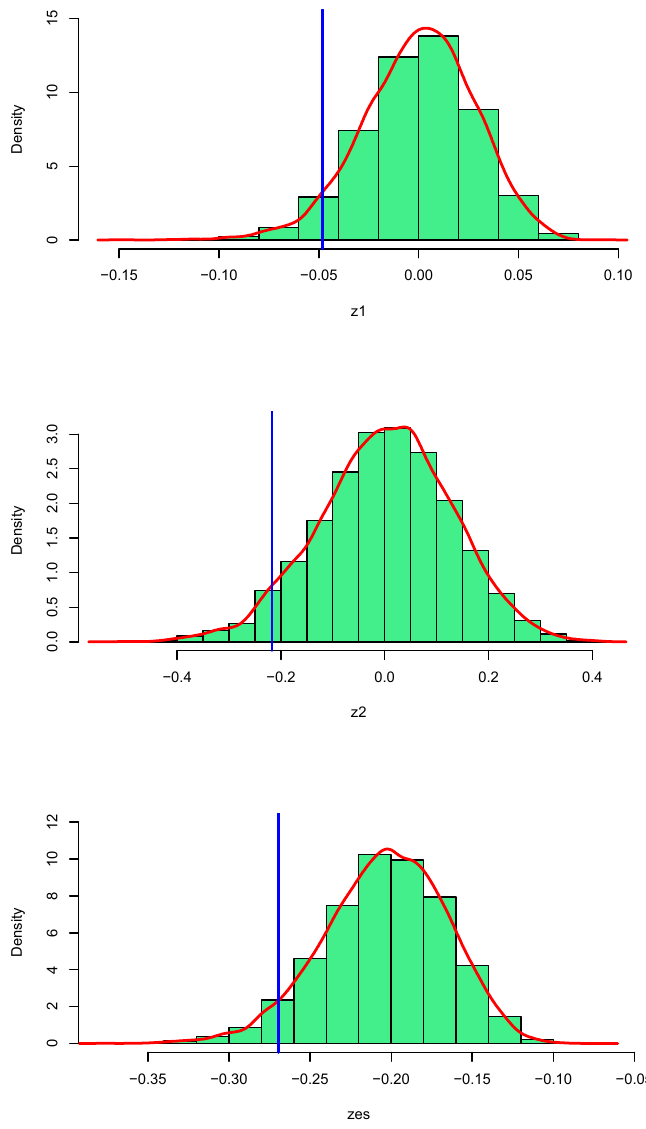
Figure 2. Critical values tests for (cid:1852) (cid:2869) ,(cid:1852) (cid:2870) and (cid:1852) (cid:3006)(cid:3020) skewed-t distribution.